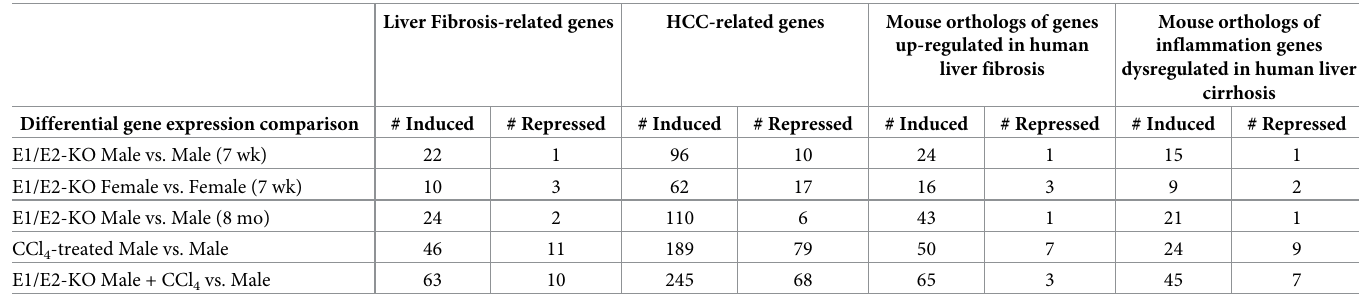
Table 1. Number of fibrosis-related or HCC-related genes induced or repressed in E1/E2-KO livers compared to wild-type controls, and/or with each of the indi- cated CCl 4 (carbon tetrachloride) treatments. Based on data in S7 Table and S8 Table. Liver Fibrosis-related genes HCC-related genes Mouse orthologs of genes